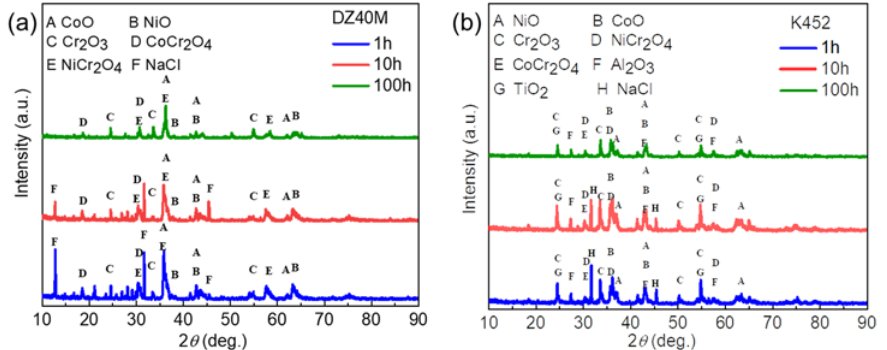
Figure 6. XRD of thermal corrosion product of DZ40M ( a ), and K452 ( b ).